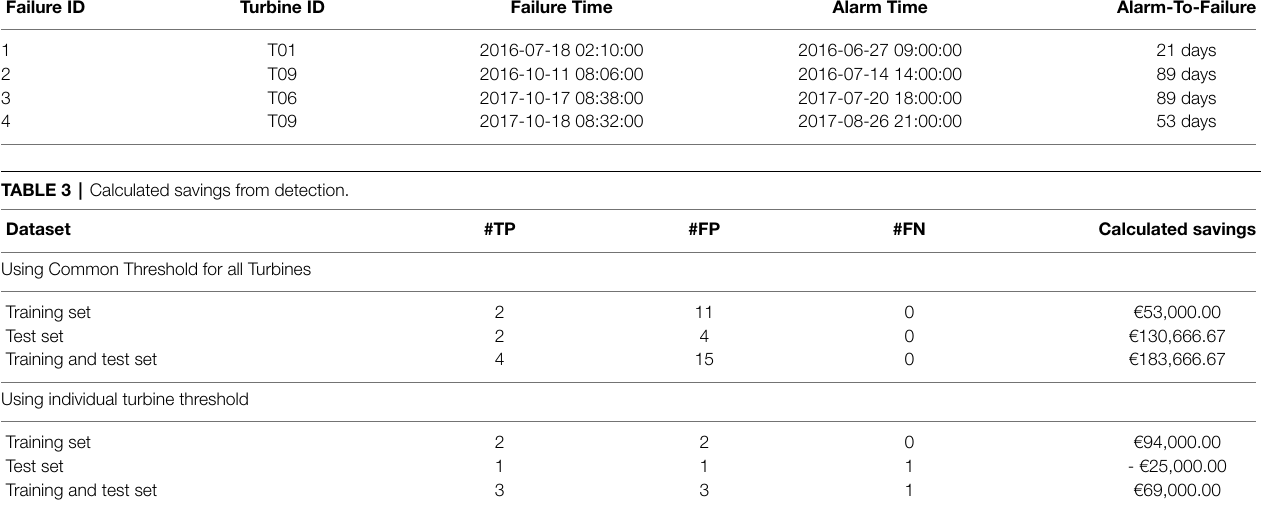
TABLE 2 | Gearbox failure detection results summary.